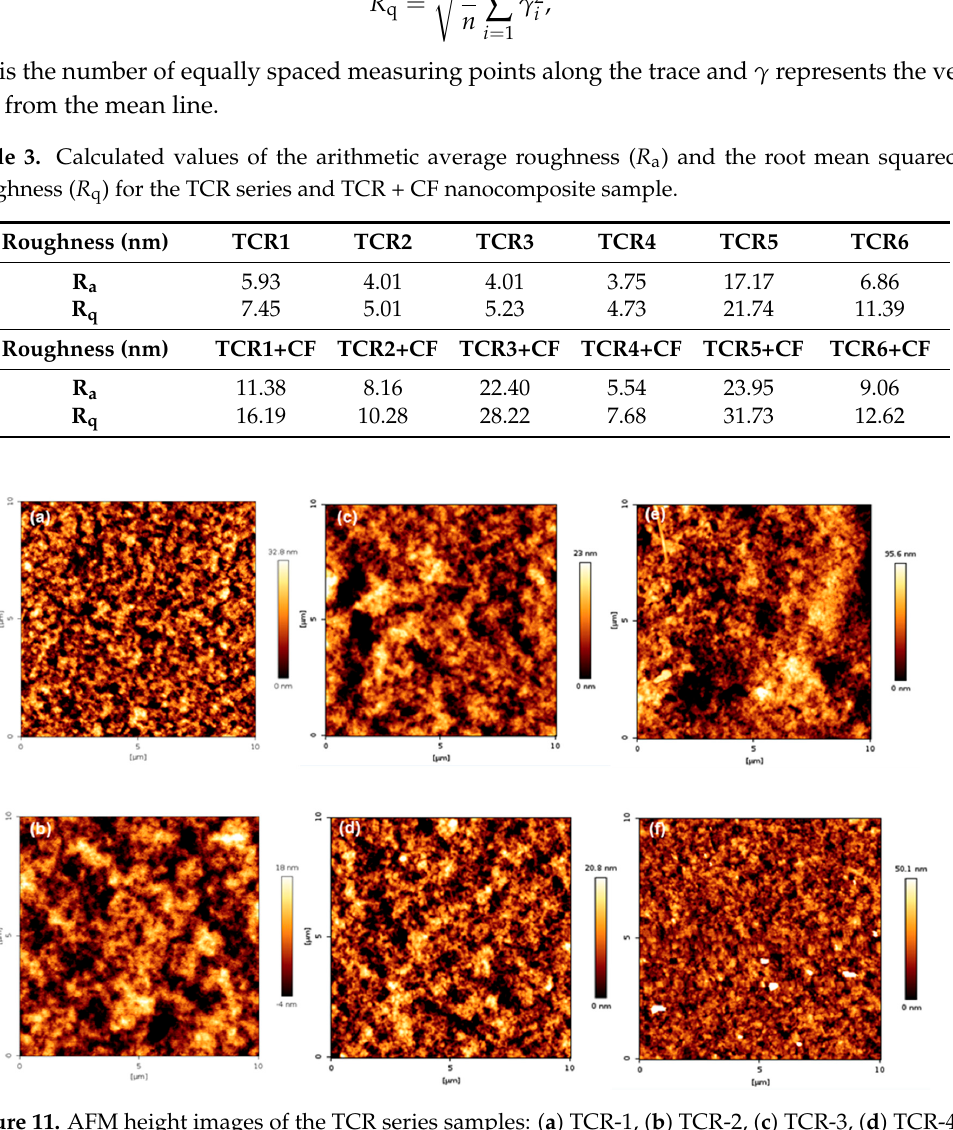
Figure 11. AFM height images of the TCR series samples: ( a ) TCR-1, ( b ) TCR-2, ( c ) TCR-3, ( d ) TCR-4, ( e ) TCR-5, and ( f ) TCR-6.